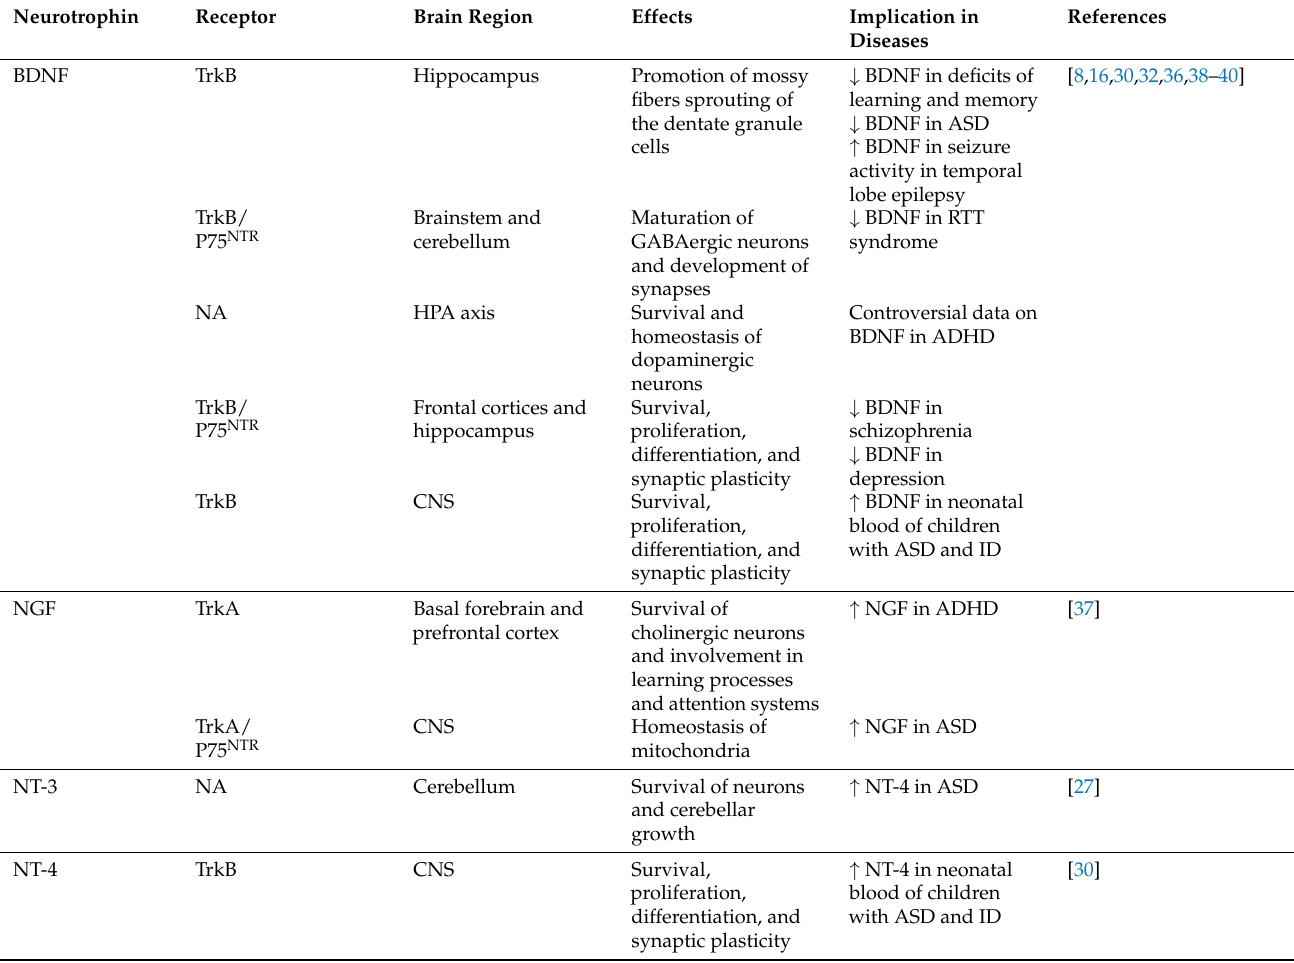
Table 1. NTs/receptors interactions and implications in brain